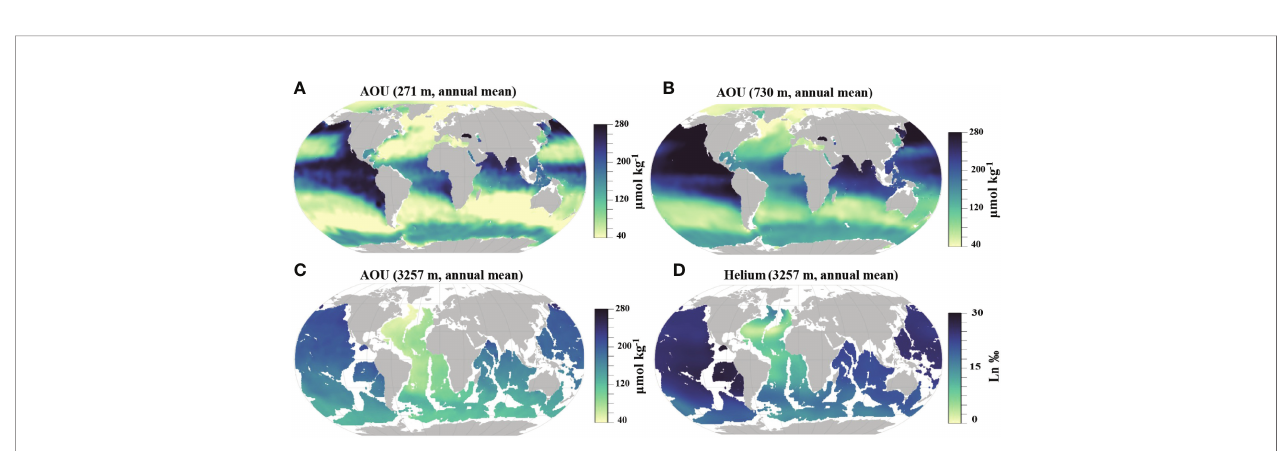
FIGURE 7 | Global distribution of apparent oxygen utilization (AOU) at 271 m (A) , 730 m (B) , 3257m (C) , and helium concentration at 3257 m (D) .